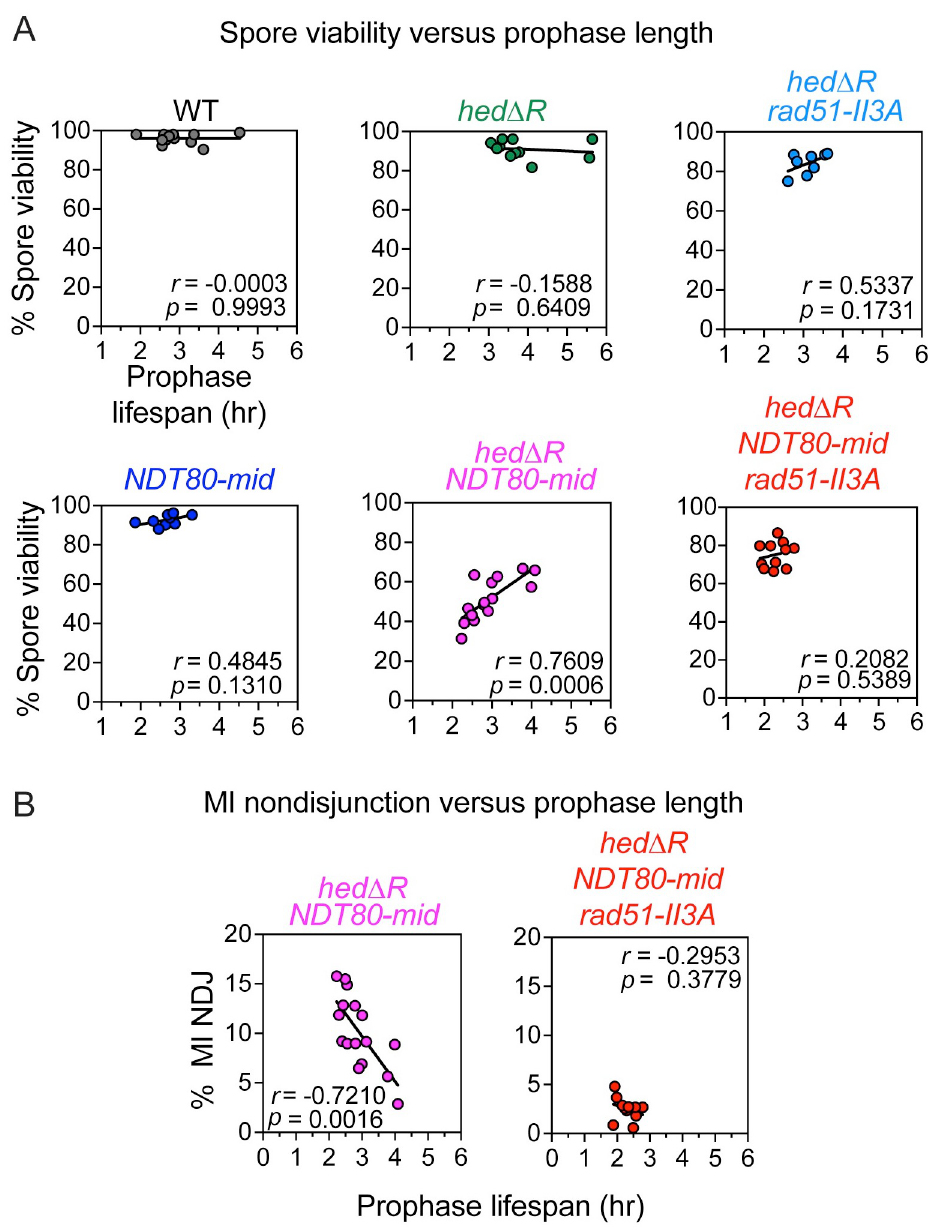
Fig 6. The meiotic recombination checkpoint uncouples prophase I length from spore viability and MI chromosome segregation when Rad51 is constitutively activated. (A) Spore viability was plotted versus prophase I length for WT ( n = 12), hed Δ R ( n = 11), hed Δ R rad51-II3A ( n = 8), NDT80-mid ( n = 11), hed Δ R NDT80-mid ( n = 16) and hed Δ R NDT80-mid rad51-II3A ( n = 11). (B) Chromosome VIII MI nondisjunction was plotted versus prophase I length for hed Δ R NDT80-mid and hed Δ R NDT80-mid rad51-II3A , using the same replicates as in Panel A. These data are from the same timecourses shown in Figs 2 and 3. The correlation coefficient and statistical significance are indicated by “ r ” and “ p ”, respectively and were determined using GraphPad Prism